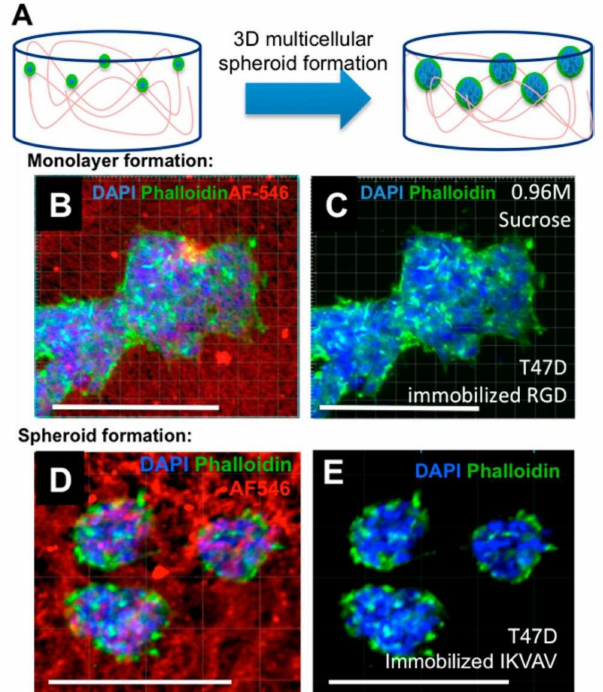
Figure 10. Scheme of cells cultured on cryogels ( A ), fluorescently labeled cryogels immobilized with peptides result in cell monolayers ( B , C ) and cellular spheroids ( D , E ). Republished with permission from [66]. Copyright 2016